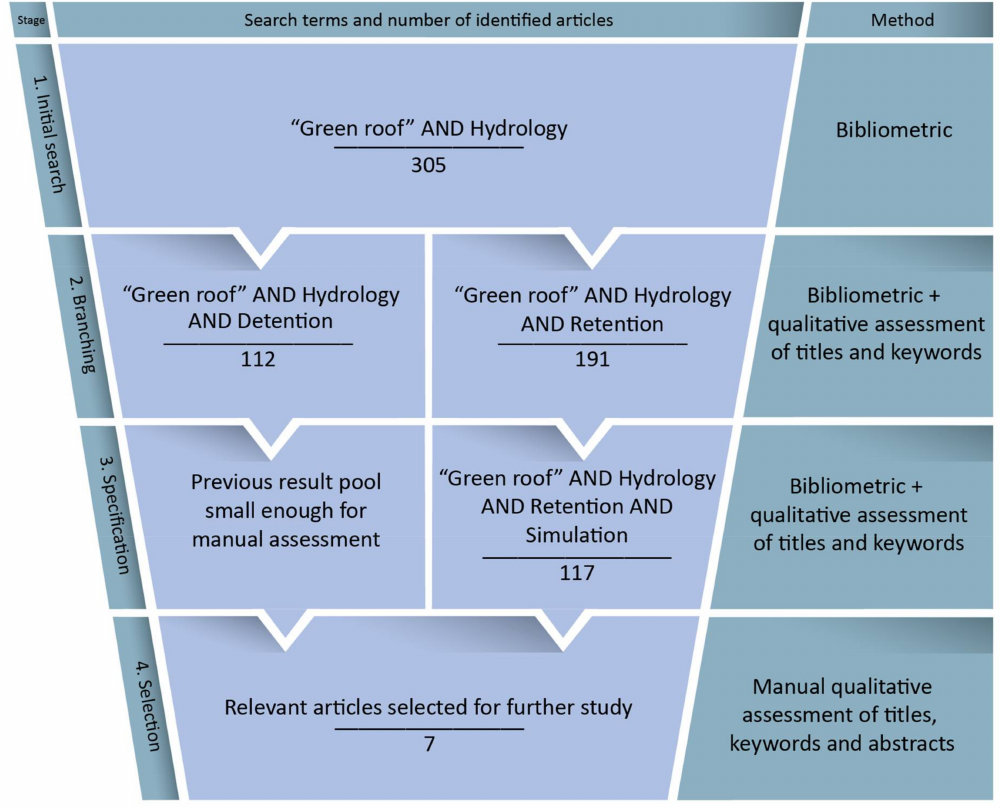
Figure 2. Example search procedure, narrowing a large number of search results into a manageable number for manual